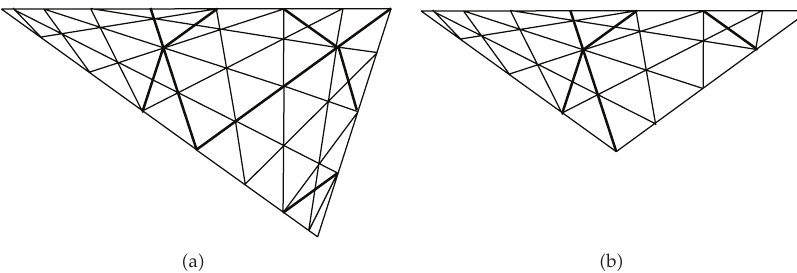
(cid:6) a (cid:7) Figure 8: Prototile subdivision by the 20-system is represented with thin lines and the thicker line indicates the possible tile